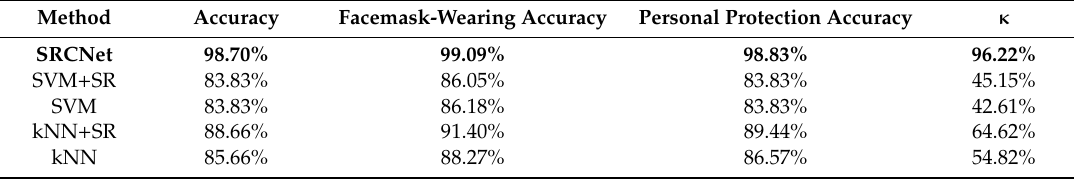
Table 9. Comparison with none-deep learning method.